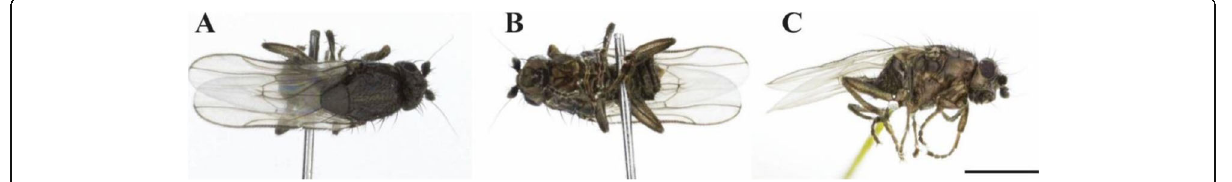
Fig. 1 Phthitia empirica adults. Dorsal ( a ), ventral ( b ), and lateral ( c ) view (scale bar 500 μ